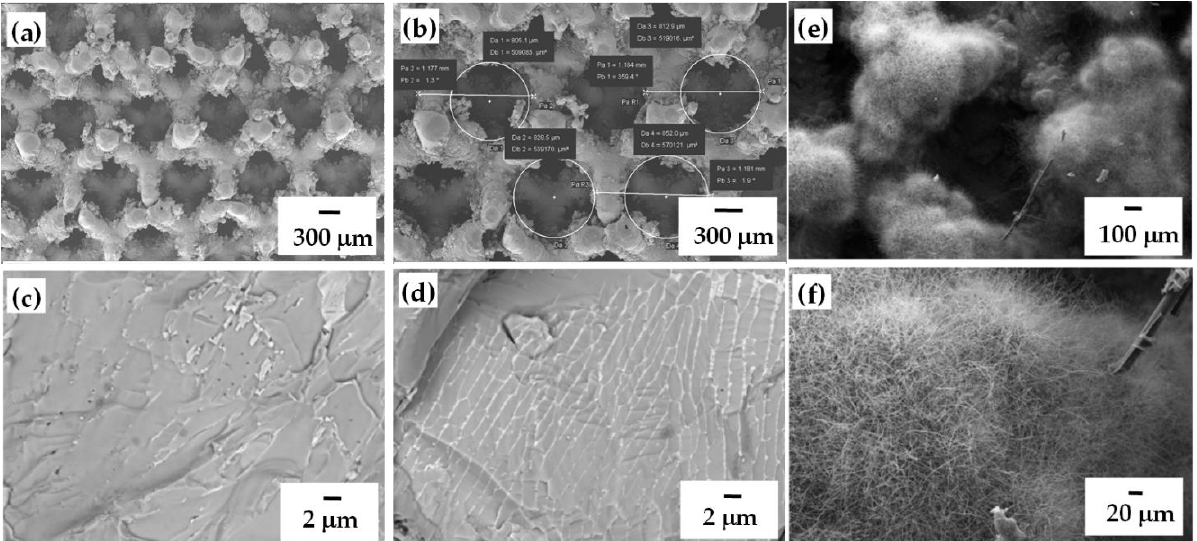
Figure 2. SEM image of SLMed MoSi 2 /Si lattice at I =3500 mA with different magnifications ( a , b ) adopted from [36]), cross section of the wall ( c , d ); single cell preview after nitridation ( e , f ).